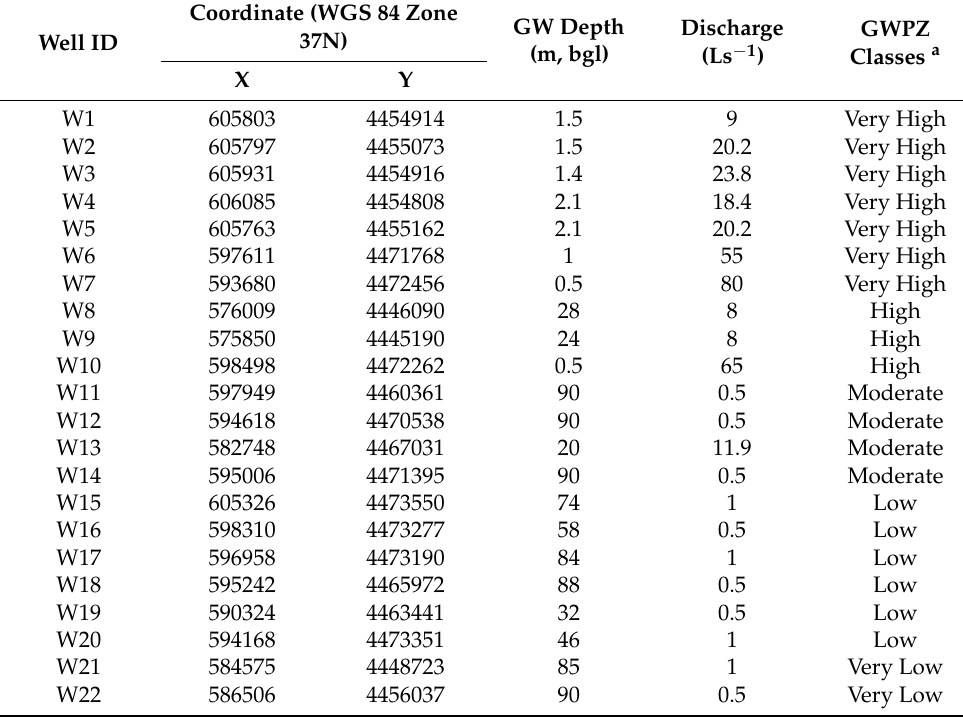
Table 7. The data of groundwater wells located in the